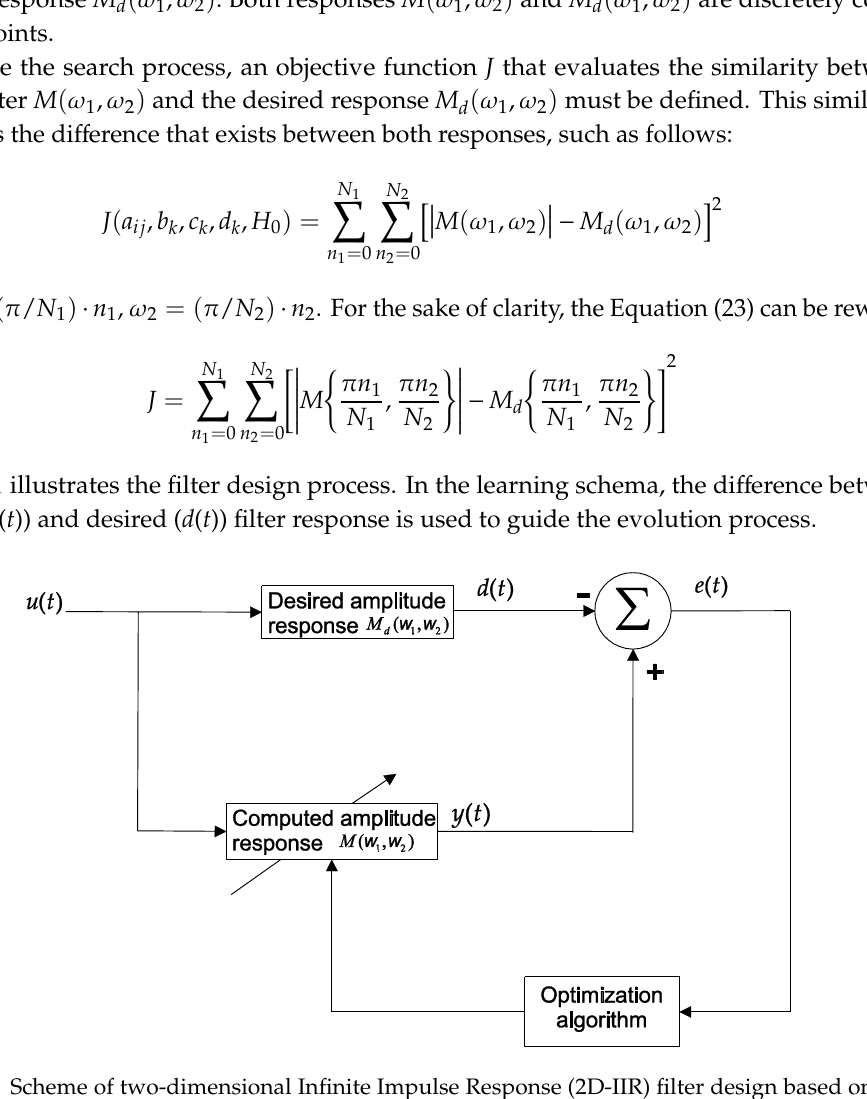
Figure 1. Scheme of two-dimensional Infinite Impulse Response (2D-IIR) filter design based on the desired amplitude response.